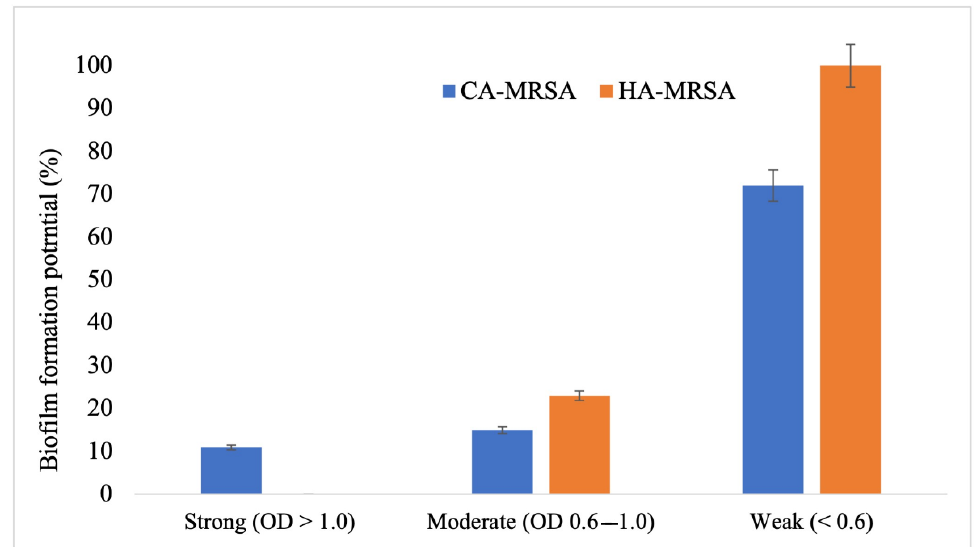
Figure 2. Biofilm production of CA-MRSA and HA-MRSA isolates using the Microtiter Plate method.